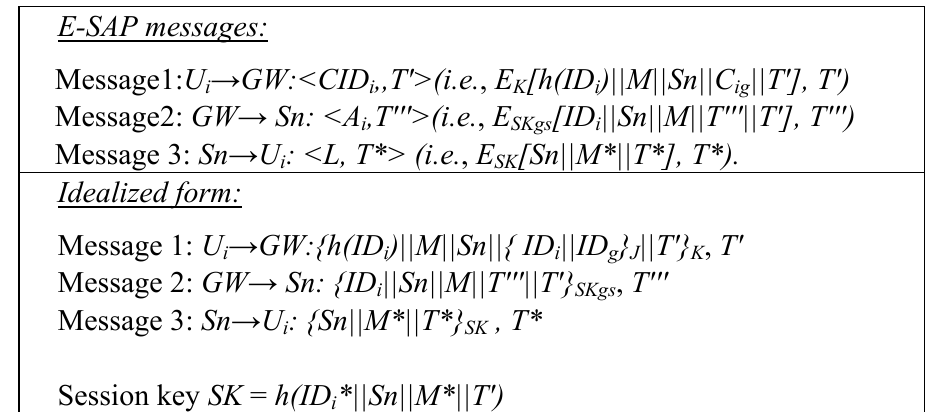
Table 2. E-SAP messages transform into the idealized